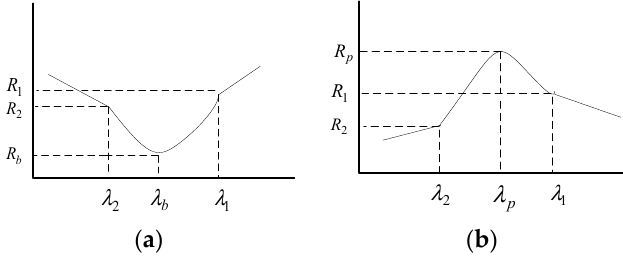
Figure 4. Schematic of spectral absorption index (SAI) ( a ) and spectral peak height (SPH) ( b ).